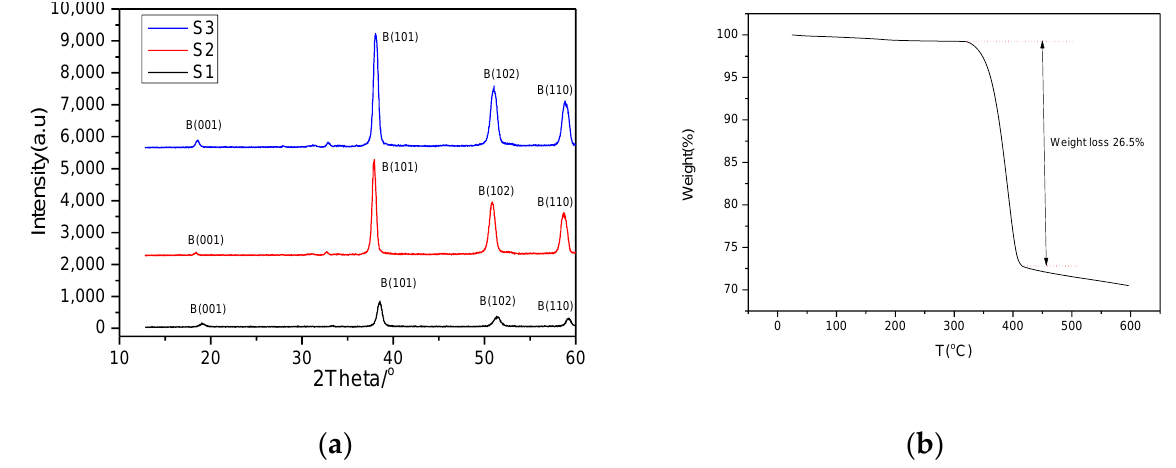
Figure 2. ( a ) X-ray diffraction pattern and ( b ) Thermogravimetric analysis (TGA) of the solid ob- tained from the hydrothermal treatment of three magnesium oxide (MgO) samples S1, S2 and S3; B: Brucite; hydrothermal treatment conditions 190 °C, 13 bar, 1 h. As shown in Figure 2a, all test samples of MgO (S1, S2 and S3) following hydrother- mal treatment were converted into brucite, the characteristic reflections of which are ex- hibited in the powder XRD. The composition of the solid was confirmed by the thermo- graphic analysis. TGA analysis for all three samples was identical and is shown in Figure 2b. The first series of measurements of the kinetics of struvite precipitation, refer to the precipitation of struvite from supersaturated solutions, in which magnesium was sup- plied by the addition of the residual suspension of the hydrothermal treatment of MgO, to the solution of NH 4 H 2 PO 4 (Method A). Both magnesium and solution pH decreased immediately as a function of time, reaching the plateau values shown in Figure 3.